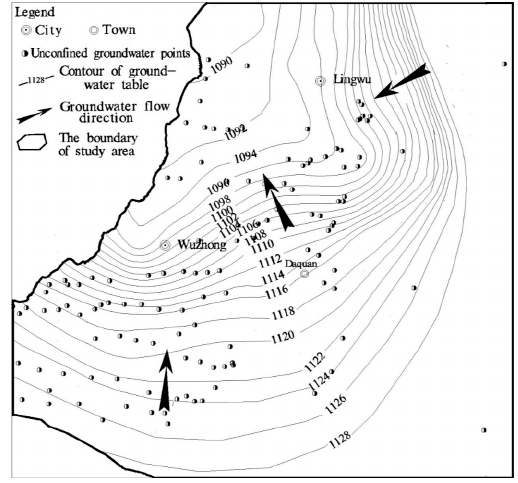
Figure 4. Unconfined groundwater contour lines.